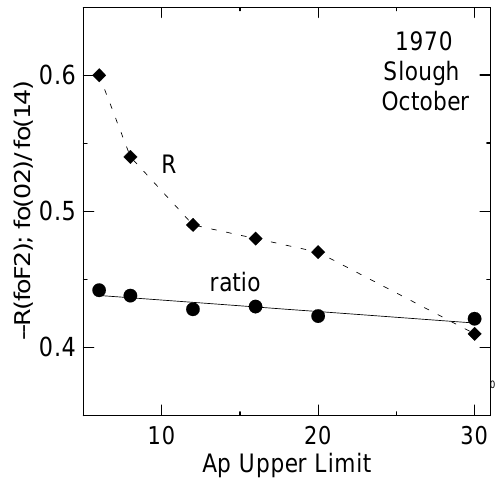
Fig. 9. Variations with the limiting value of A p in R ( fo F2) and fo F2(02)/ fo F2(14) for the fall period of 1970 at Slough.